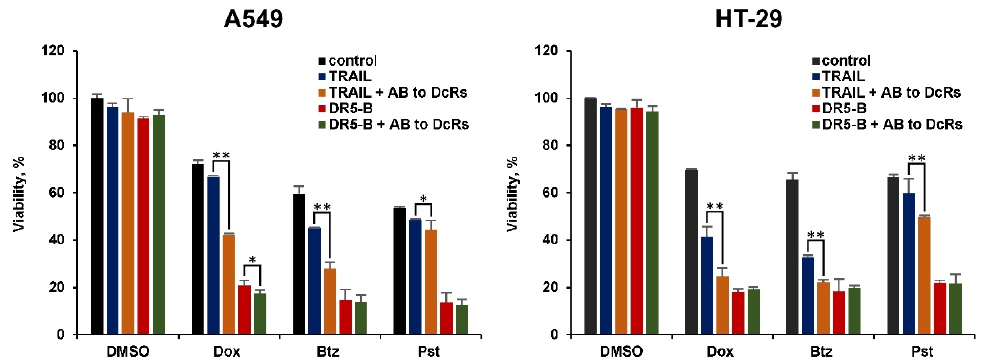
Figure 6. Neutralization of decoy receptors improved TRAIL cytotoxic activity. A549 and HT-29 cells were pre-incubated with 1500 nM and 2500 nM doxorubicin (Dox), 50 nM and 25 nM bortezomib (Btz), 100 nM and 50 nM panobinostat (Pst) respectively for 24 h, following incubation with anti-DcR1 and anti-DcR2 antibodies (15 µg/mL each) for 1 h and 1000 ng/mL ligands for another 24 h. Mean ± Standard Deviation ( n = 3). The asterisks indicate significance (* p < 0.05) and (** p < 0.001) relative to cells treated with ligands without anti-DcRs antibodies.